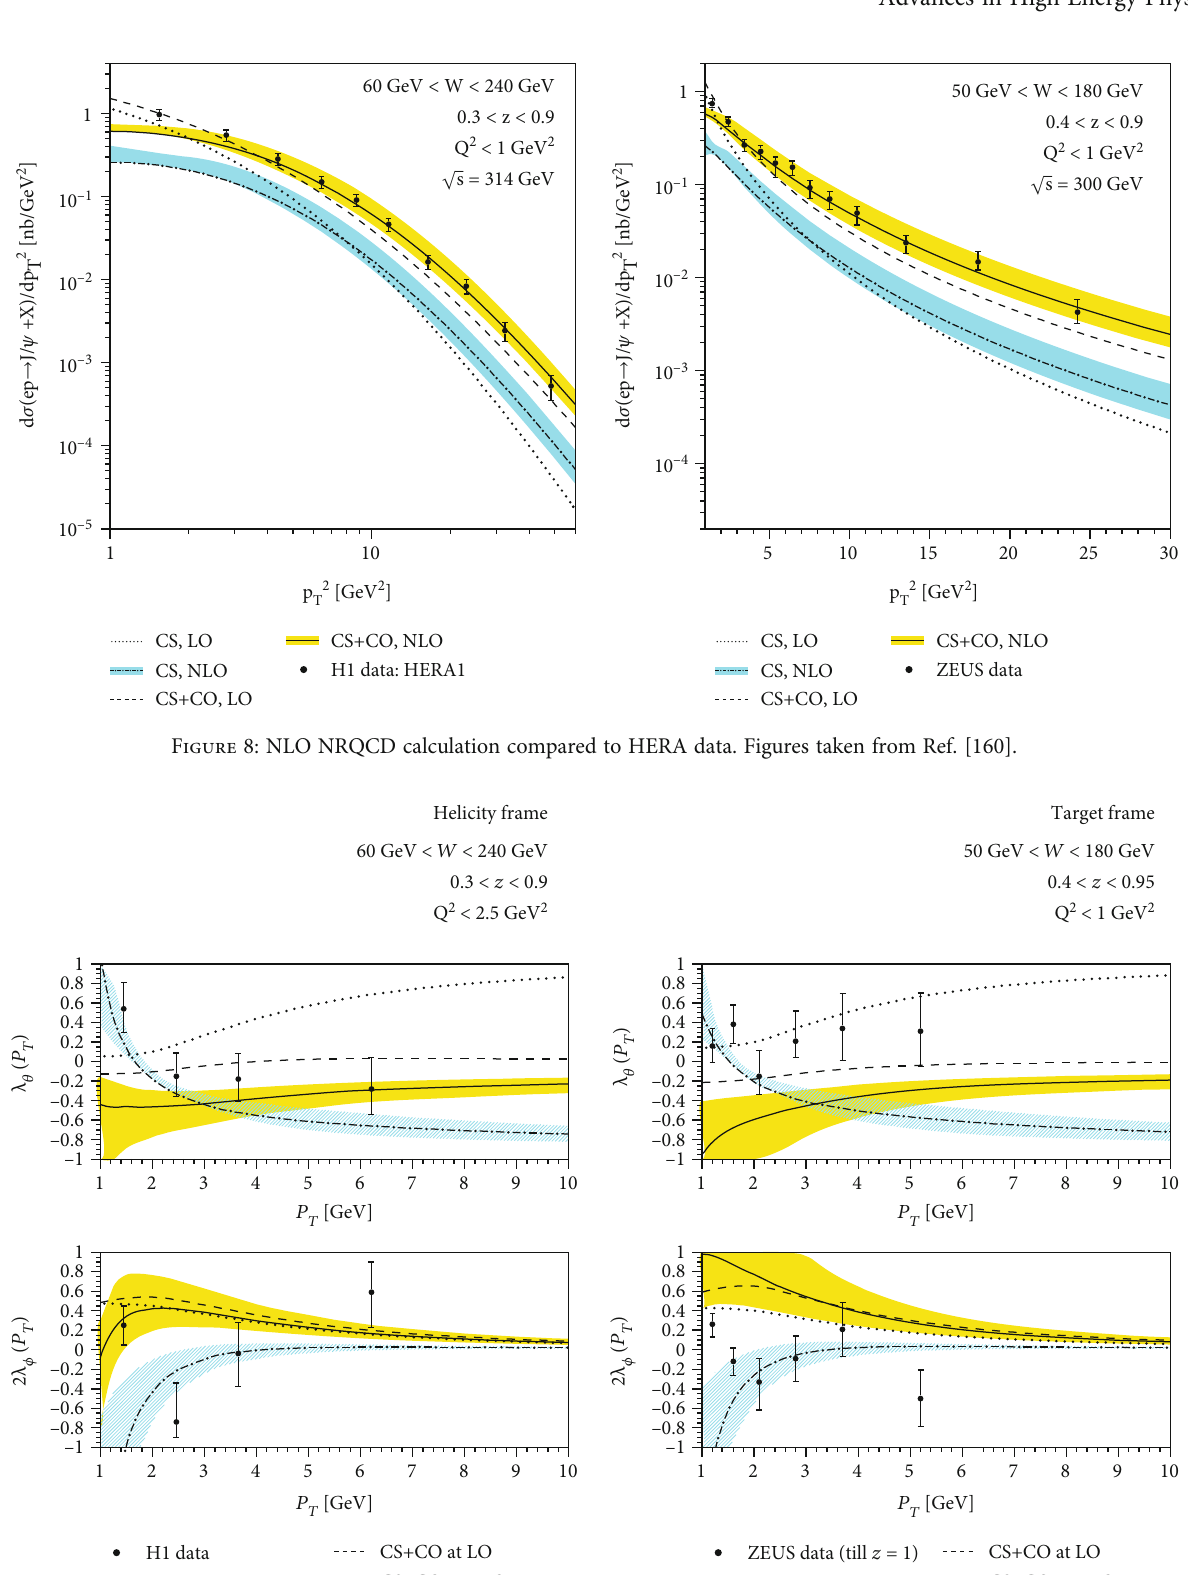
compared to H1 [97] and ZEUS [164] data. Figures T